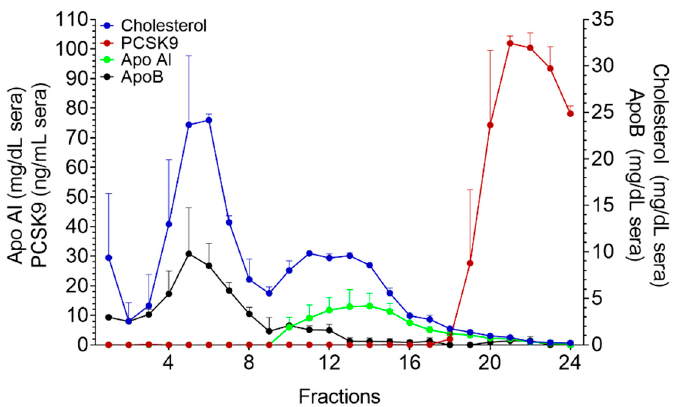
Figure 1. KBr gradient ultracentrifugation. Cholesterol, PCSK9, ApoB and Apo AI profile of LP fractions isolated with KBr gradient ( n = 4). Data were reported as mean + SEM.